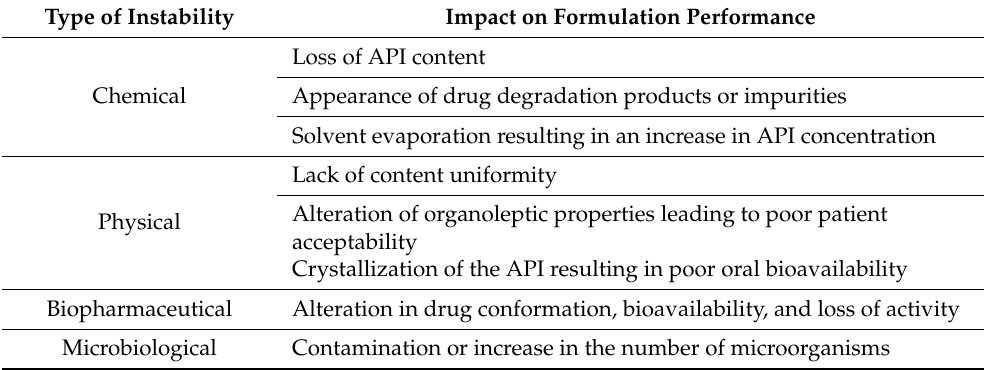
Table 1. Impact of drug instability in liquid formulations